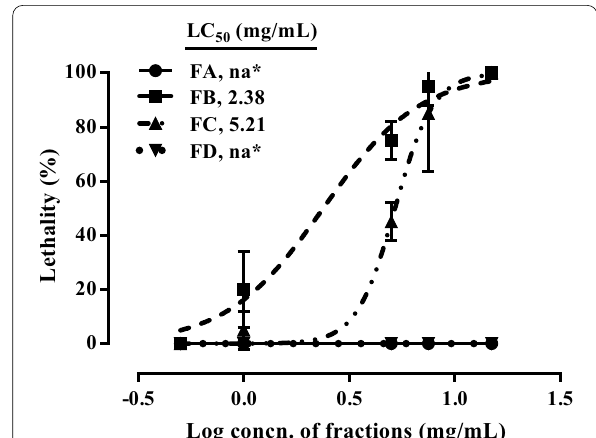
Fig. 4 Anthelmintic activities of Vernonia amygdalina leaf extracts (CE—chloroform extract; AE—acetone extract) against adult Haemonchus placei . Each value represents two replicates of two independent experiments after 3-h exposure to varying concentrations (0.5–20 mg/mL) at ambient temperature (26 ‒ 30 °C)